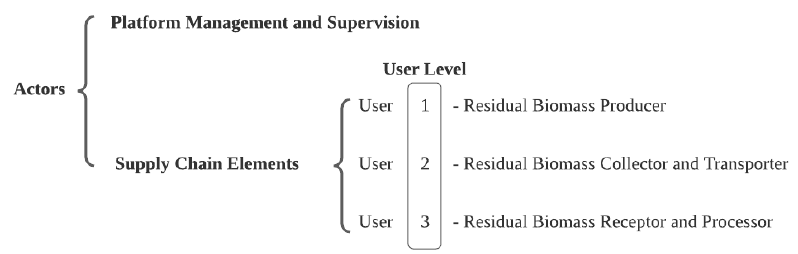
Figure 6. Definition of actors and different levels of intervention.